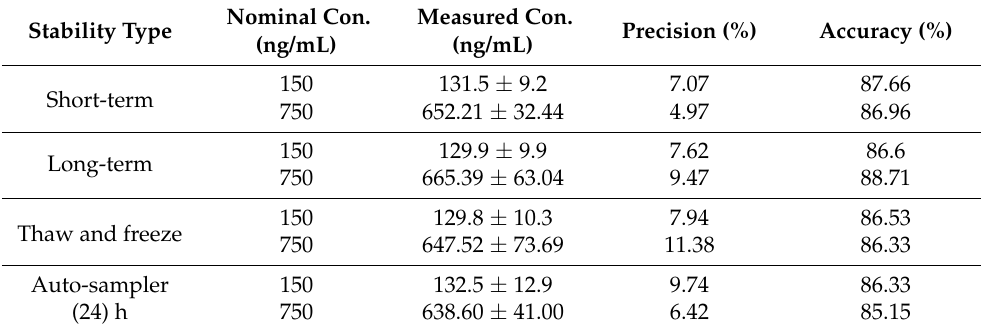
Table 4. Stability of PX in plasma under different storage conditions.